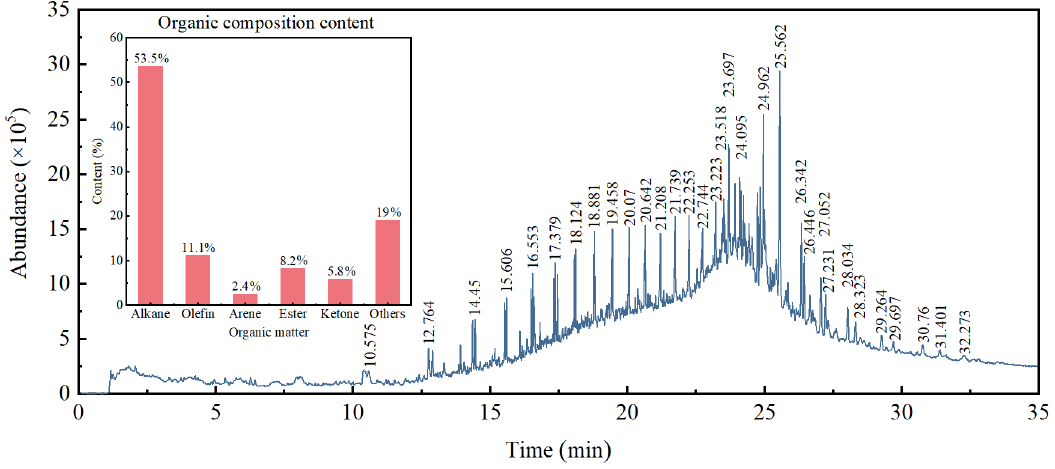
Figure 7. The spectrum of organic matters in oily sludge.